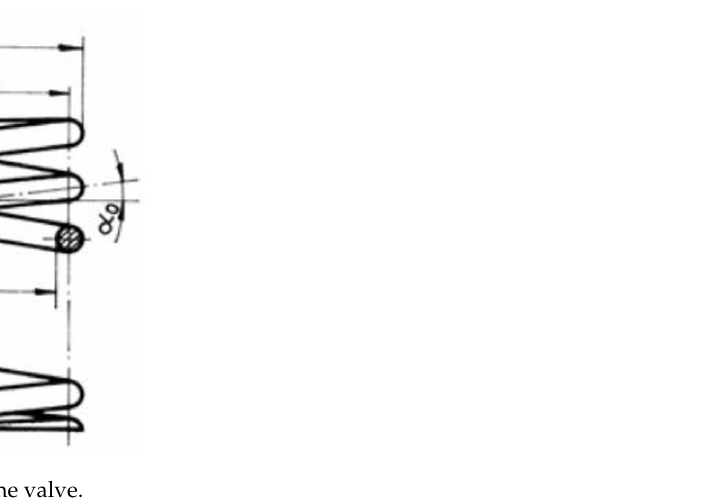
Table 4. Determination of the elastic characteristic of the valve spring.